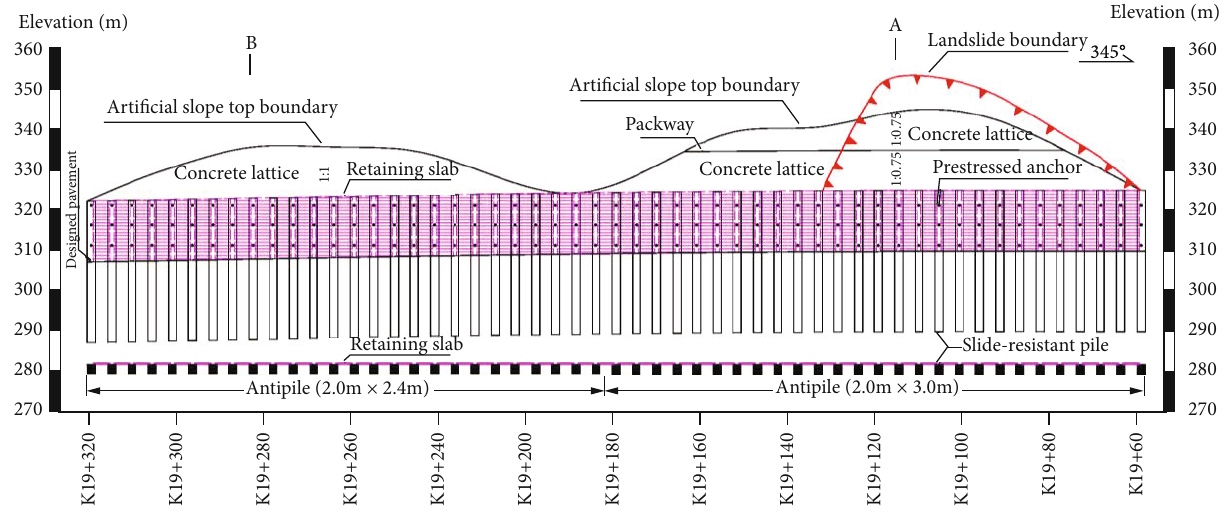
Figure 2: The elevation layout of the reinforcement